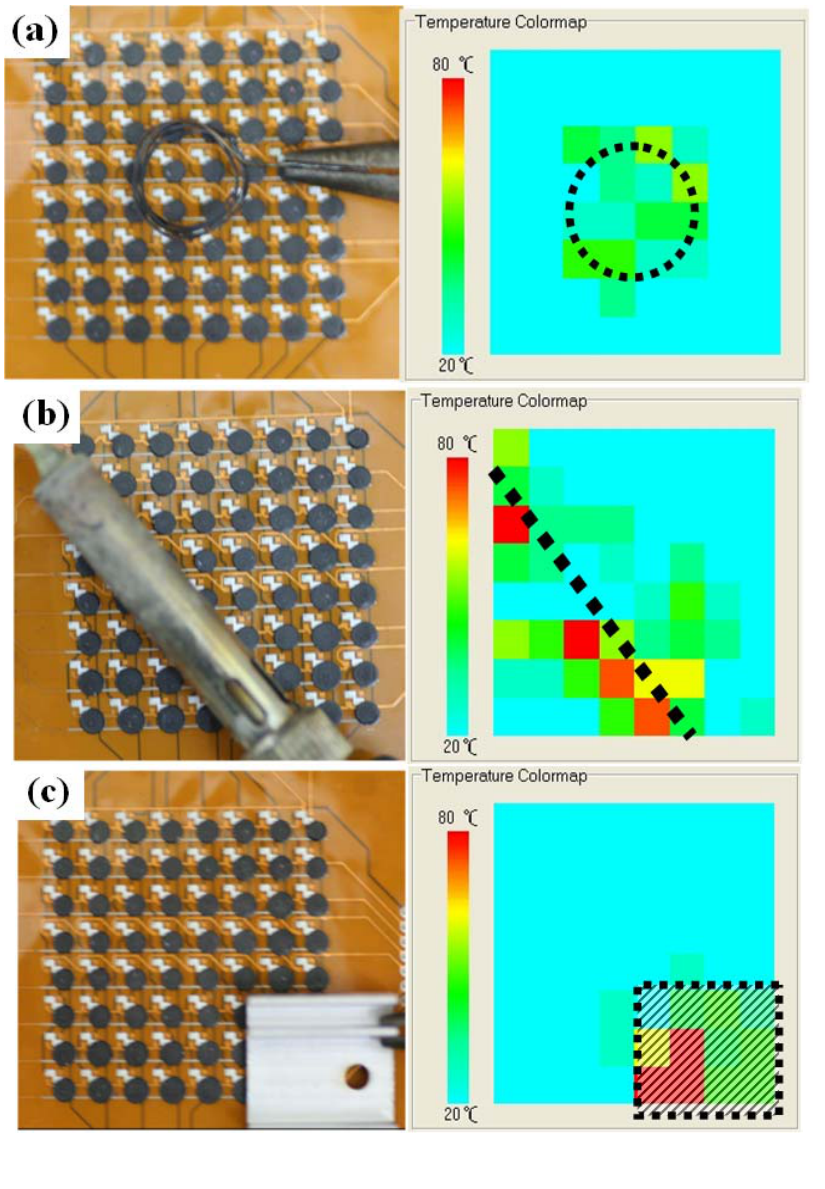
Figure 11. Measured temperature distributions of the fabricated sensor array subjected